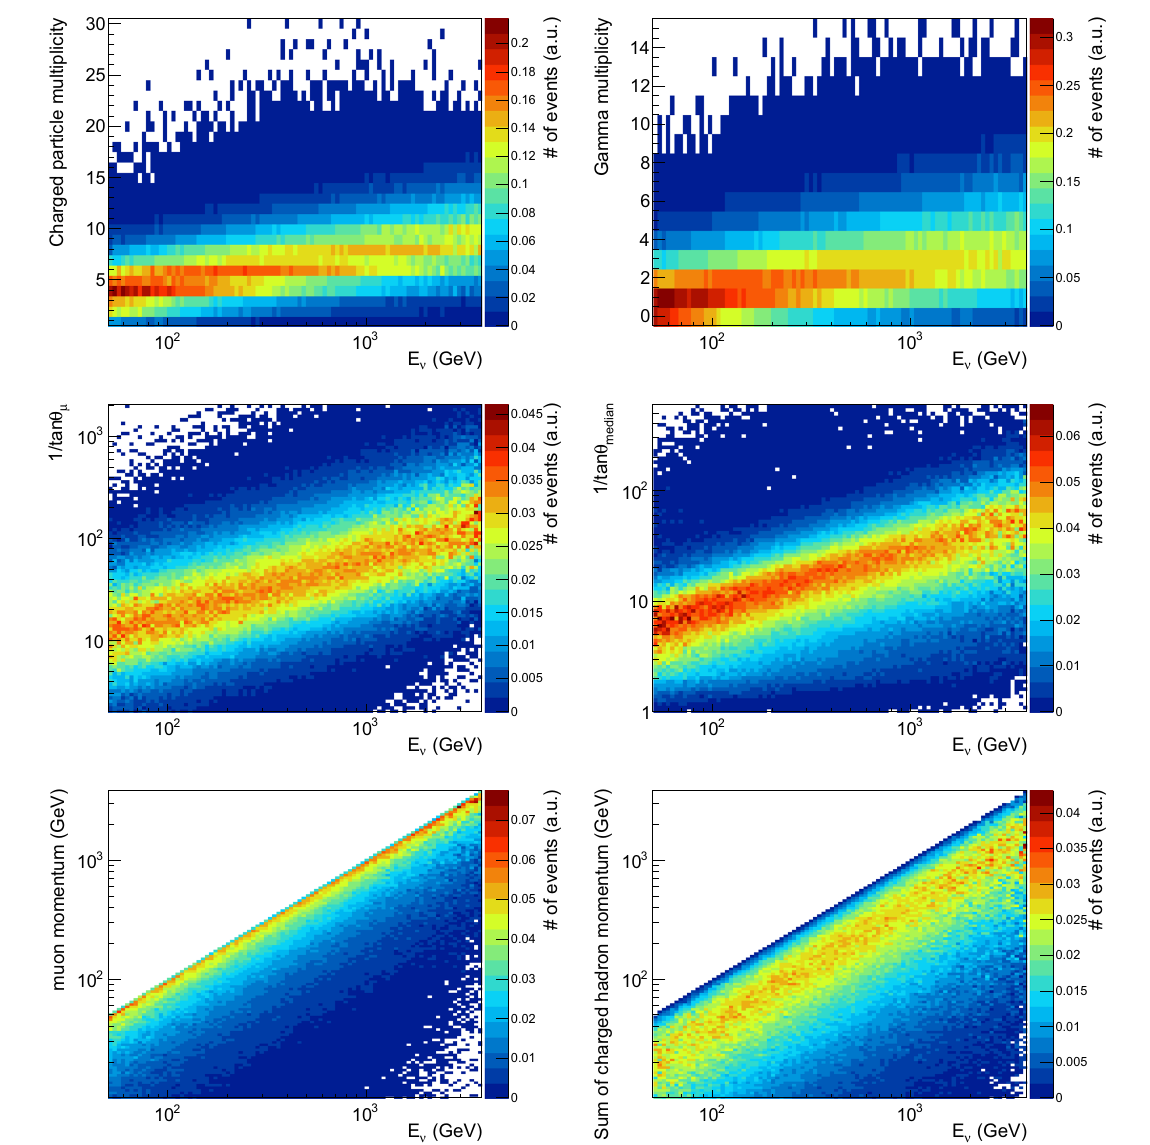
Fig. 8 Topological and kinematic features of neutrino interactions as a function of the simulated neutrino energy (“MC truth”). As an exam- ple, the distributions of ν μ CC interactions are shown. Upper panels : The multiplicity of charged particle tracks and γ rays with momentum